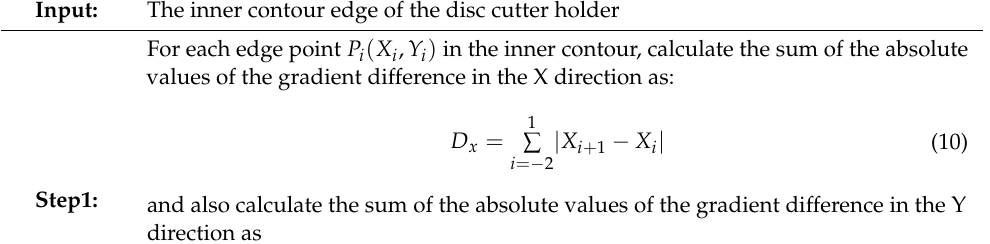
Table 2. The steps of the rectangular search box generation method.